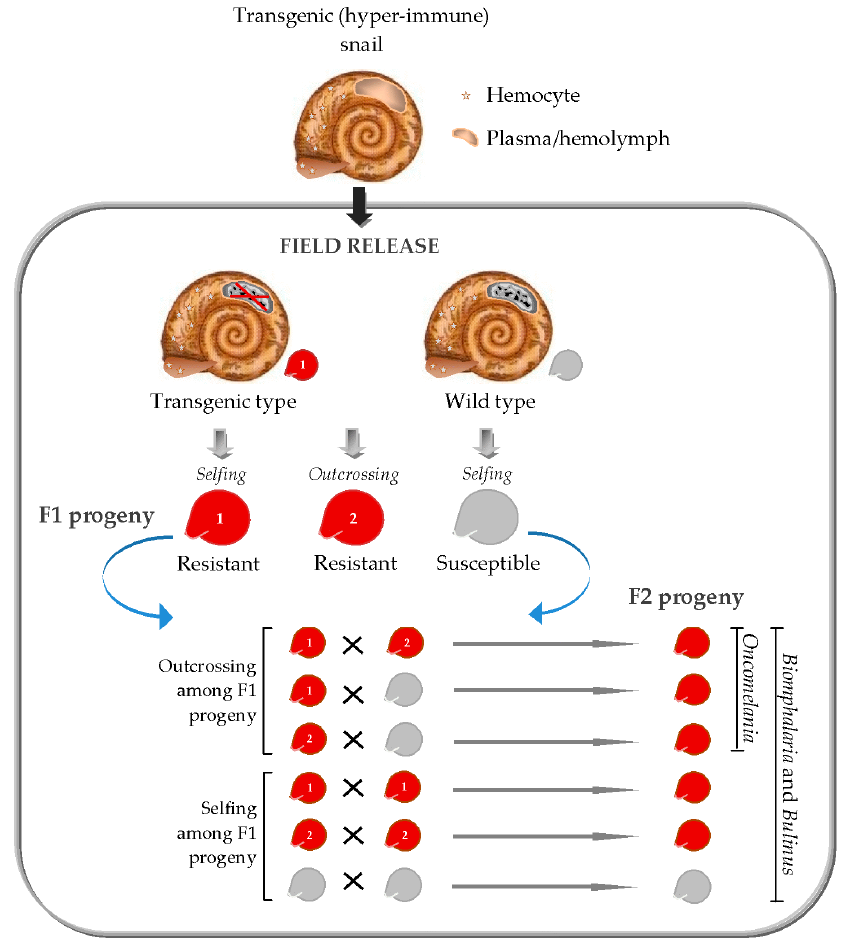
Figure 1. Transgenic snail system for field control of schistosomiasis transmission.